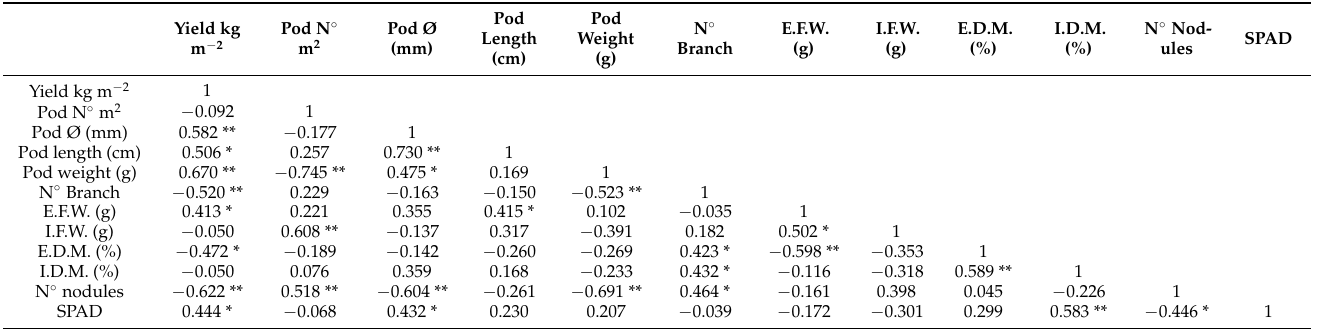
Table 3. Pearson’s correlations of the characteristics